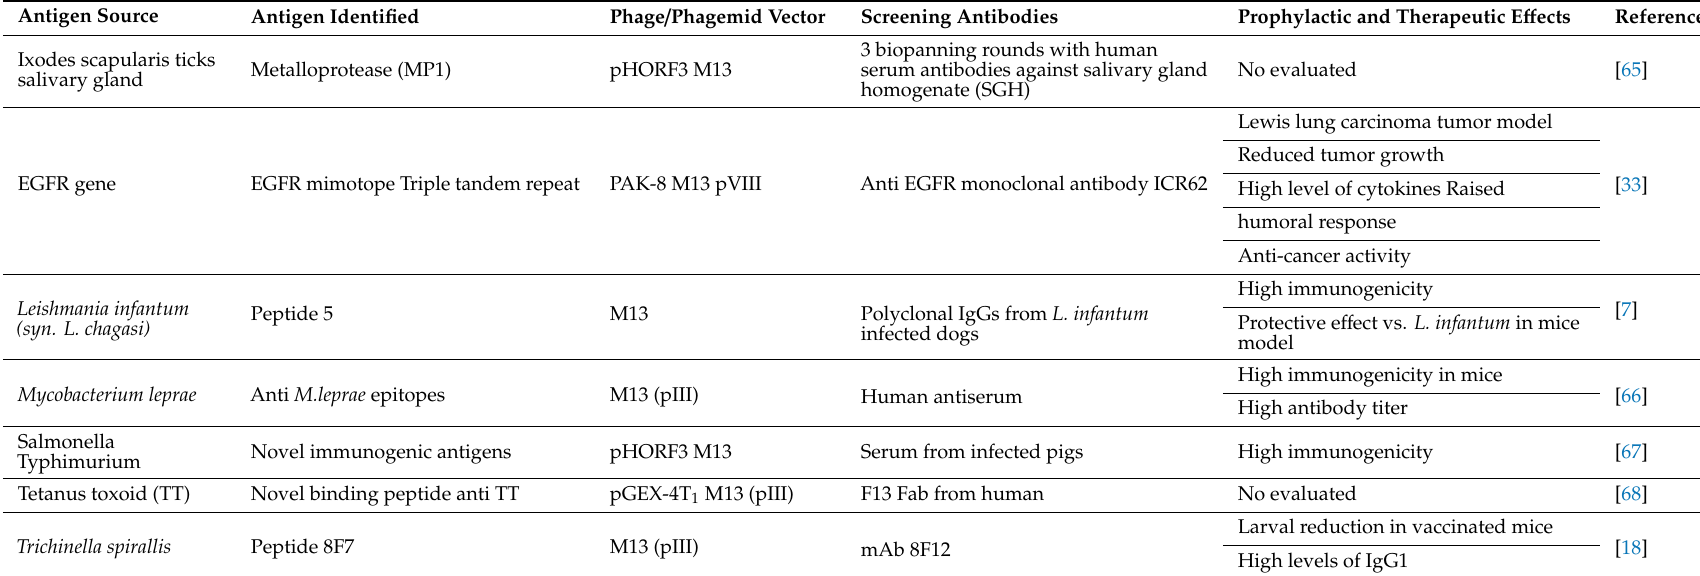
Table 3. Cases of epitope, mimotope and antigens identification through phage display describing the main findings in regards of the phage display protocol used for selection and the prophylactic and therapeutic results